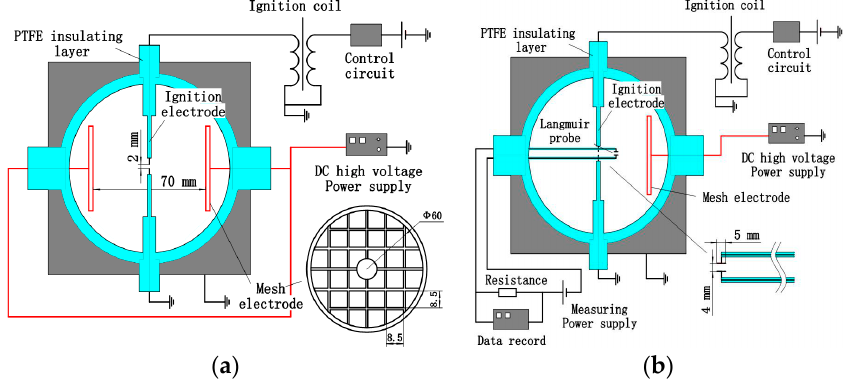
Figure 2. Electrode arrangement in the combustion chamber: ( a ) two mesh electrode type; and ( b ) one mesh electrode one Langmuir probe type.